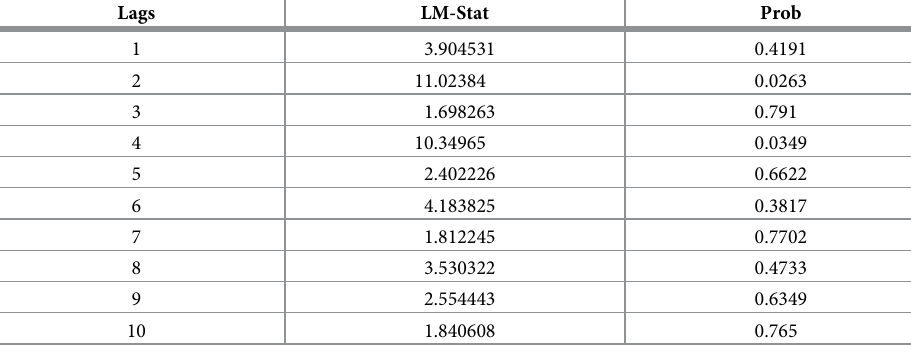
Table 13. Serial correlation LM test for Australian data when P = 1 (Fisherian